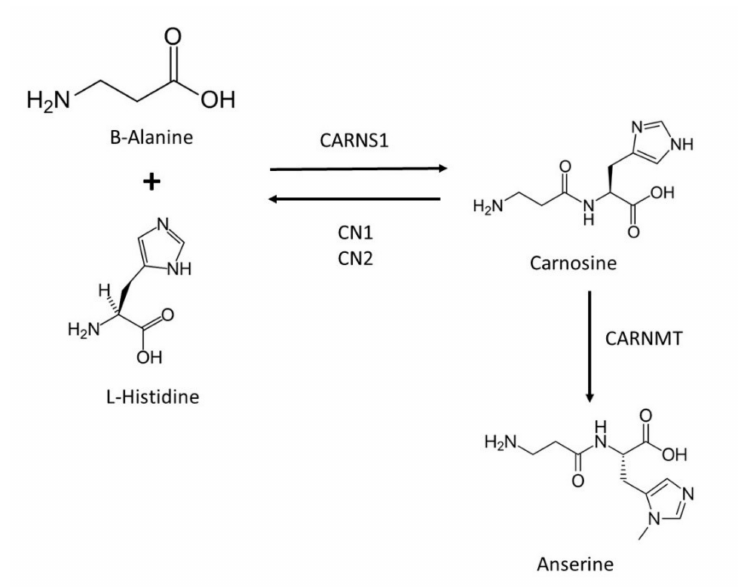
Figure 1. Schematic illustration of carnosine